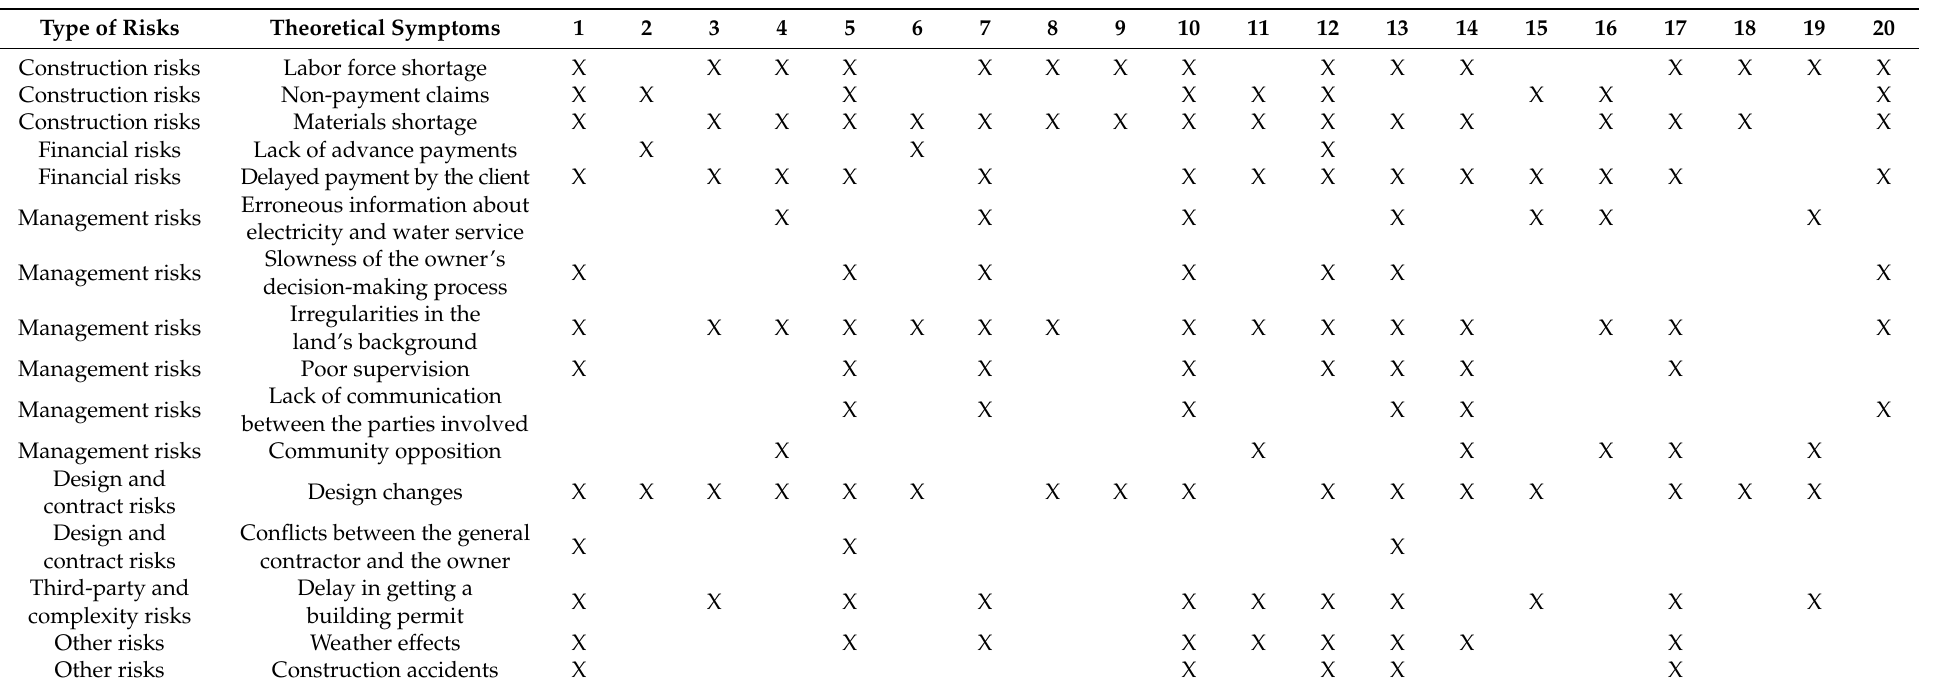
Table 1. Theoretical symptoms of